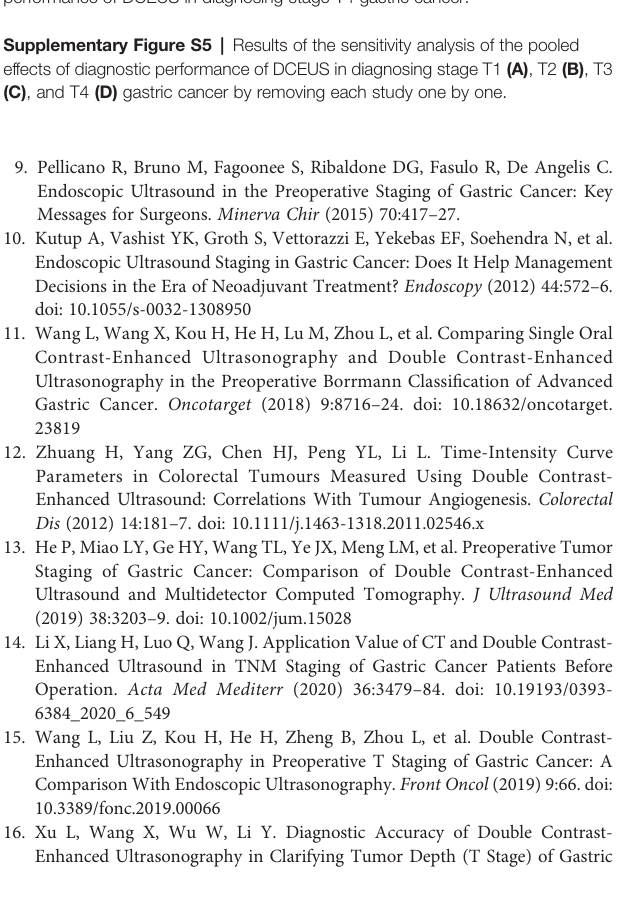
Supplementary Figure S1 | Forest plot to show the pooled effects of diagnostic performance of DCEUS in diagnosing stage T1 gastric cancer. Supplementary Figure S2 | Forest plot to show the pooled effects of diagnostic performance of DCEUS in diagnosing stage T2 gastric cancer. Supplementary Figure S3 | Forest plot to show the pooled effects of diagnostic performance of DCEUS in diagnosing stage T3 gastric cancer. Supplementary Figure S4 | Forest plot to show the pooled effects of diagnostic performance of DCEUS in diagnosing stage T4 gastric cancer. Supplementary Figure S5 | Results of the sensitivity analysis of the pooled effects of diagnostic performance of DCEUS in diagnosing stage T1 (A) , T2 (B) , T3 (C) , and T4 (D) gastric cancer by removing each study one by